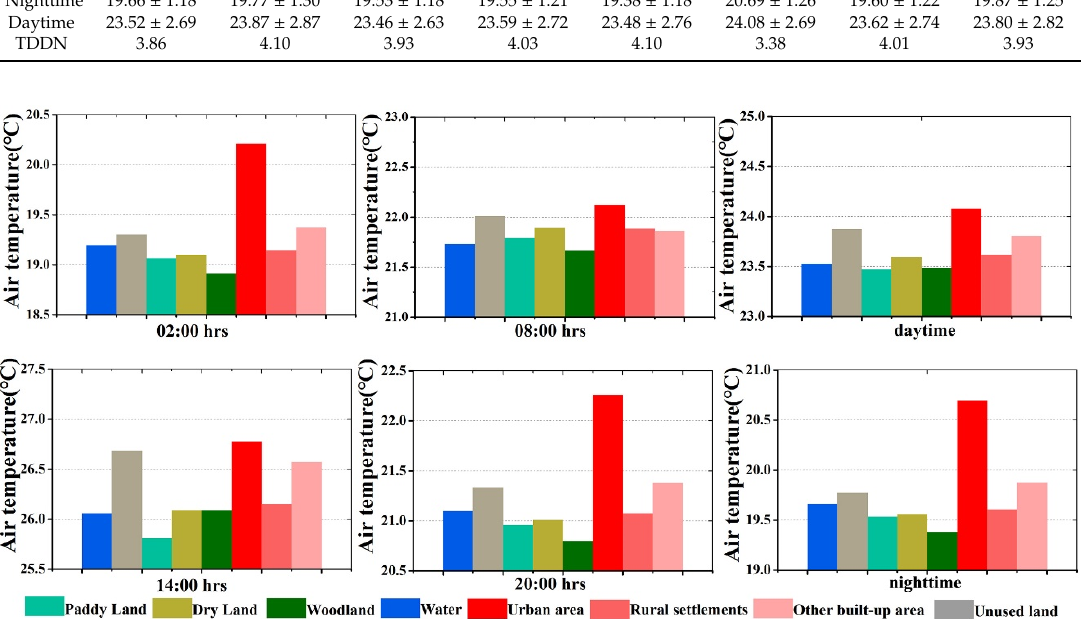
Figure 10. The air temperature among land use types at different times. Table 6. Temperature at different times for different land use types (°C). The highest and lowest temperatures are highlighted with dark and light gray shadows, respectively.